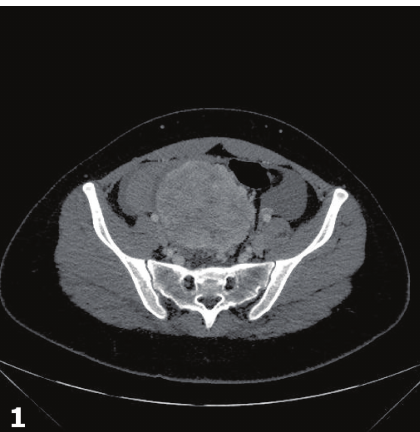
Figure 1: Computed tomography scan: There is a large irregular heterogeneous exophytic mass that appears to be arising from the right adnexa which intraoperatively arose from the serosa of the sigmoid colon.